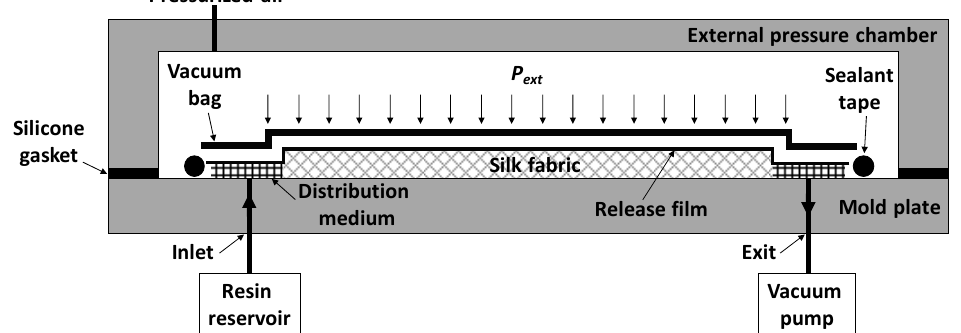
Figure 1. Experimental vacuum-assisted resin transfer molding (VARTM) setup with external pressure chamber to fabricate woven silk/epoxy composite laminates.